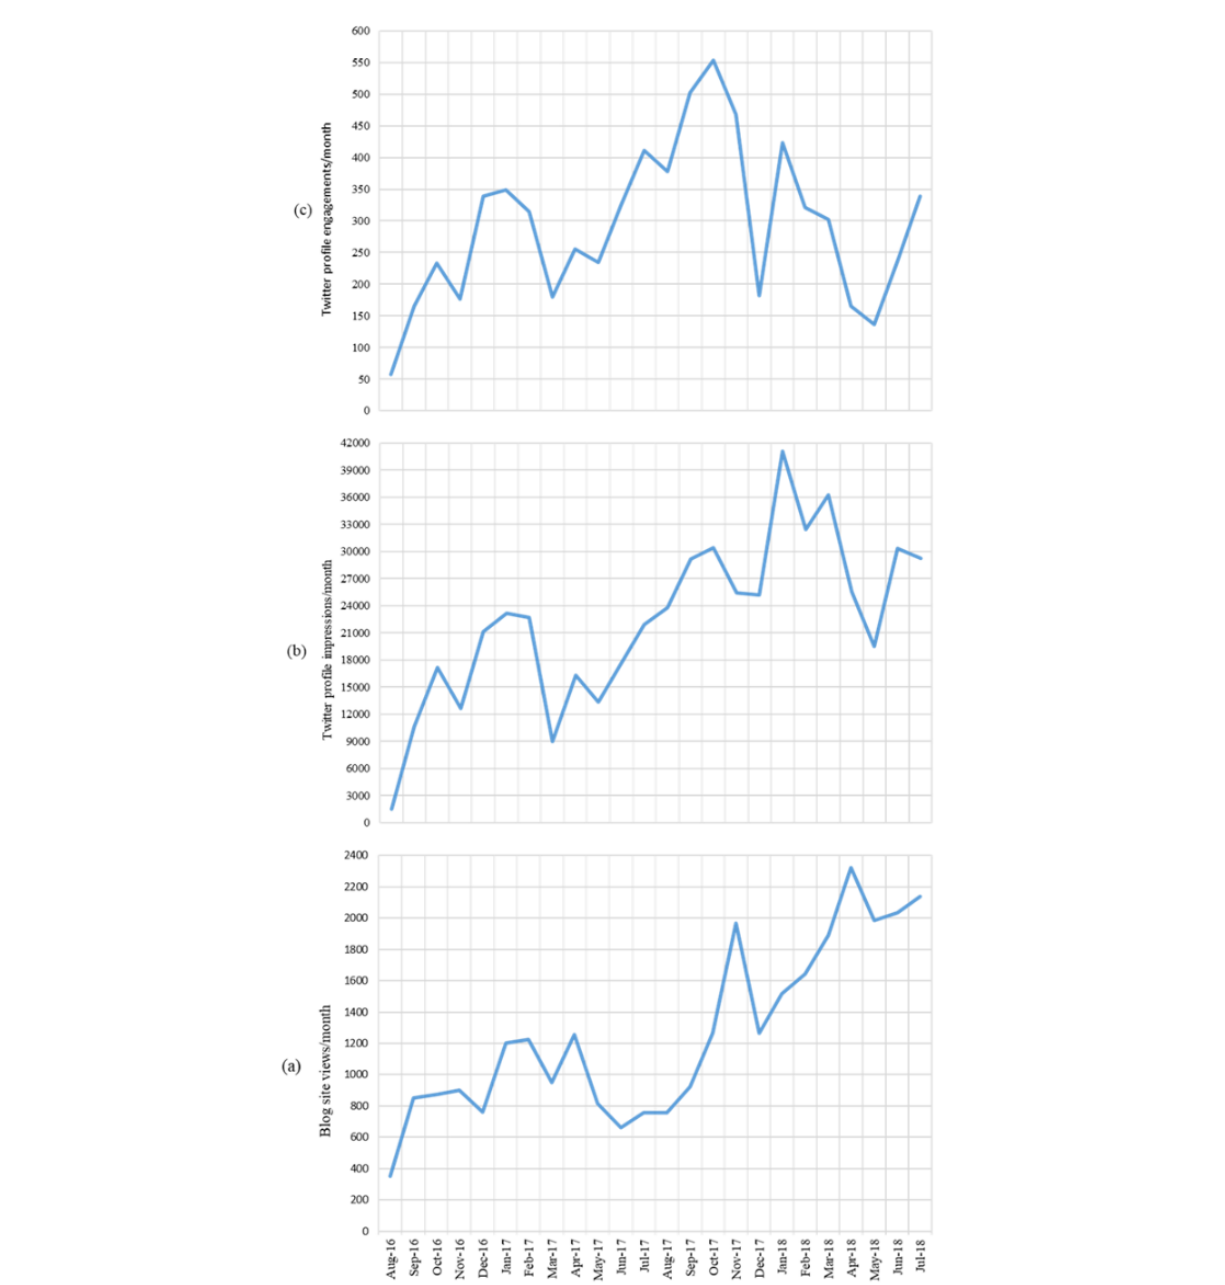
Figure 1. KnowledgeNudge blog site exposure (a), Twitter exposure (b), and Twitter engagement (c) over 2-year period. There was a significant increase in blog site exposure ( P <.001) and Twitter exposure ( P =.004) between the first and last 6 months of the study period. No significant difference was seen in Twitter engagement between the first and last 6